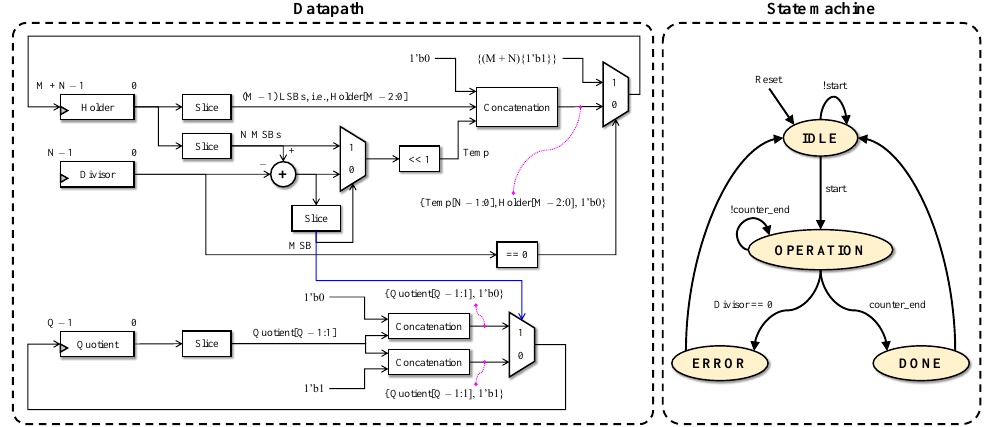
Figure A1. Datapath and state machine of the serial divider. The blue arrow is adopted to signify no intersection. MSB and LSB stand for most significant bit and least significant bit.